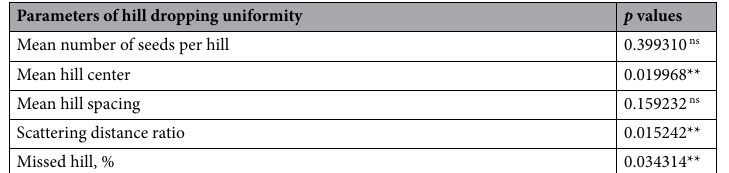
Table 3. The parameters used in the evaluation of the hill dropping uniformity of the seeder with corresponding p-values. ns ,**, nonsignificant or significant at the p ≤ 0.05, respectively.